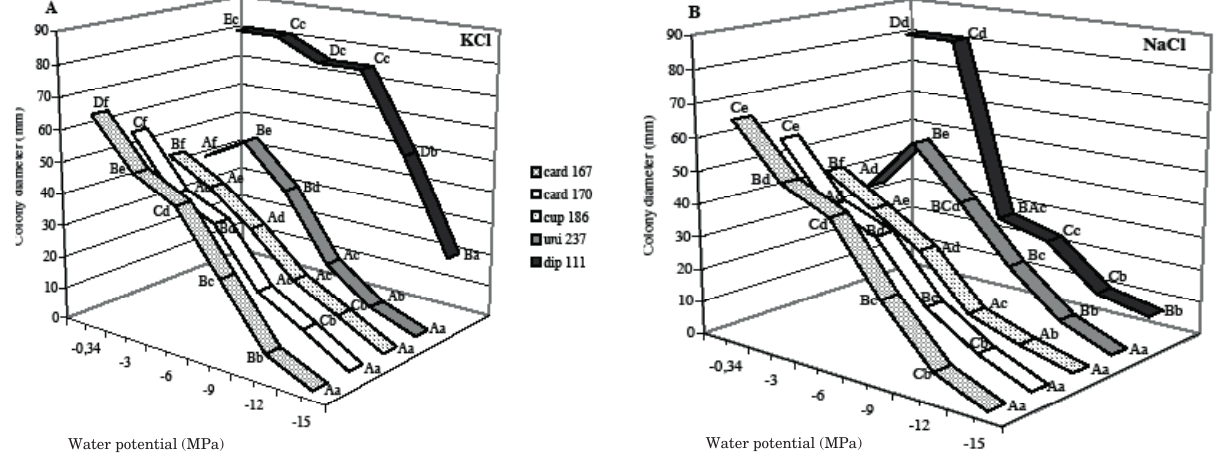
Figure 1. Mean colony diameter of Seiridium cardinale (card 167 and card 170), S. cupressi (cup 186), S. unicorne (uni 237) and Diplodia cupressi (dip 111) on PSa medium (a) amended with KCl or (B) amended with NaCl, after 21 days of incubation. The water potential of non-amended PSA was -0.34 MPa. Means accompanied by the same letter (uppercase: same treatment for different isolates; lowercase: same isolate at different treatments) are not significantly different based on Tukey test ( P